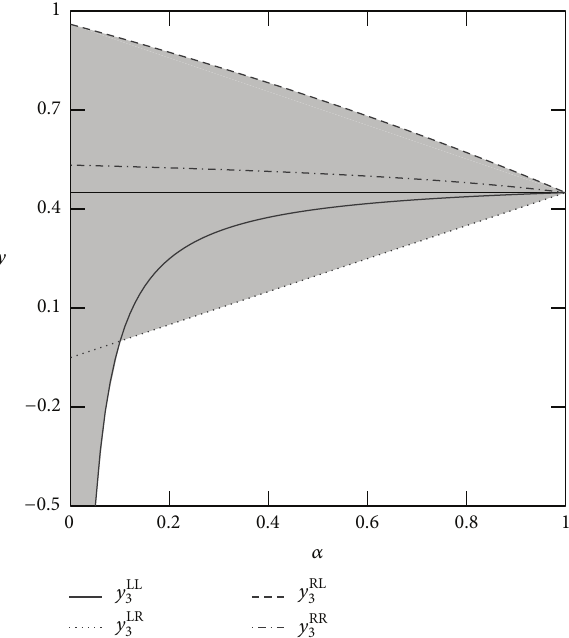
Figure 5: Solution candidates from Example